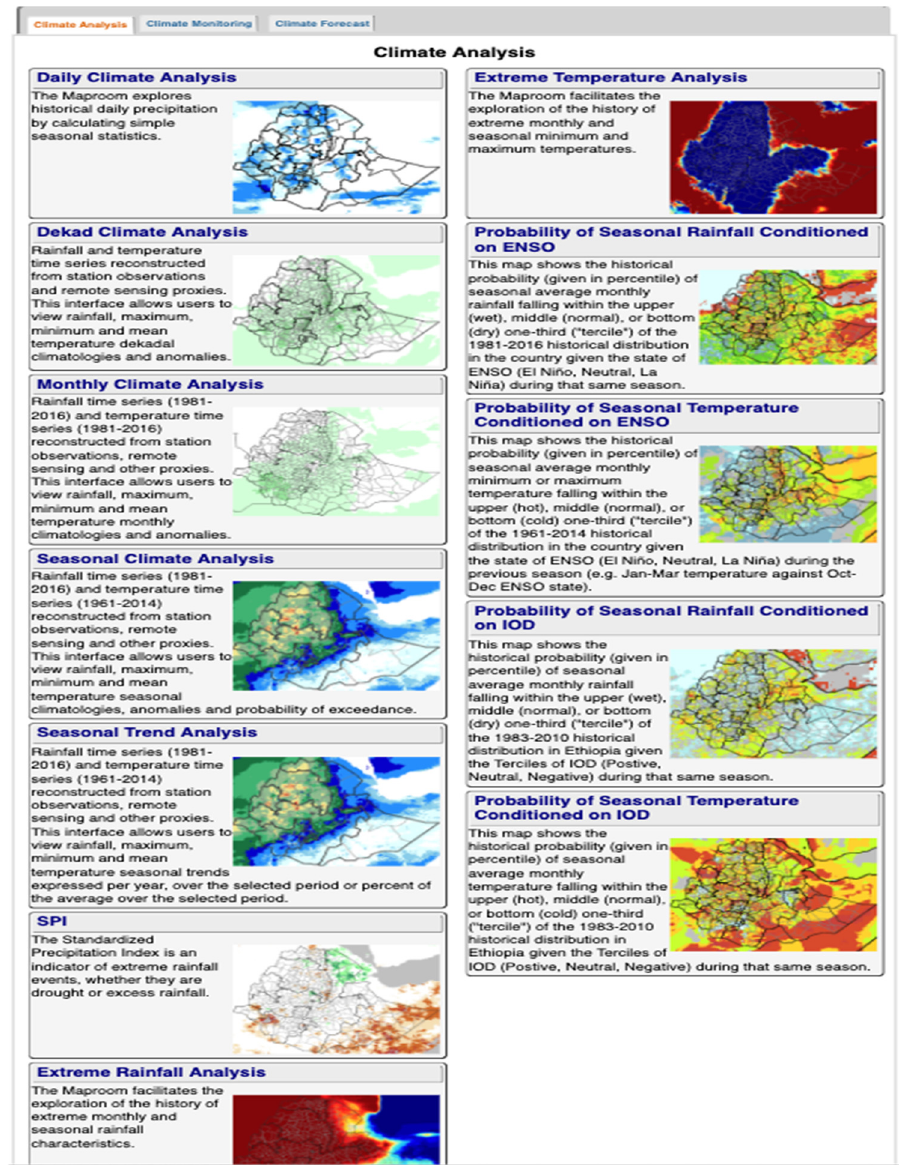
Figure 4. An example of the “Climate Analysis” maproom for